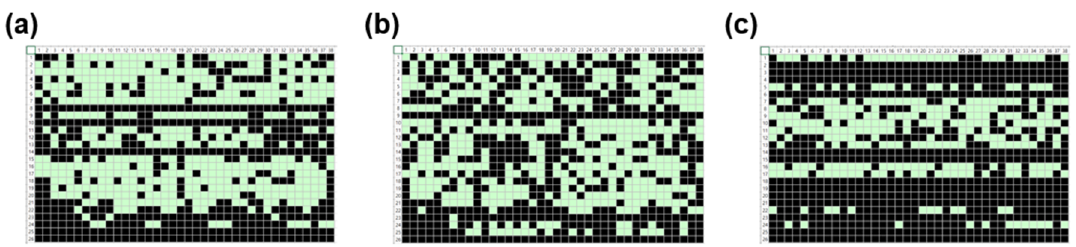
Figure 8. Statistical maps generated from PICR2R-TFT measurements of the 26 × 38 SWCNT-TFT arrays with a printing speed of 90 mm/s containing different channel lengths: ( a ) 15 µm, ( b ) 25 µm, and ( c ) 60 µm (light box: “pass”, dark box: “fail”).